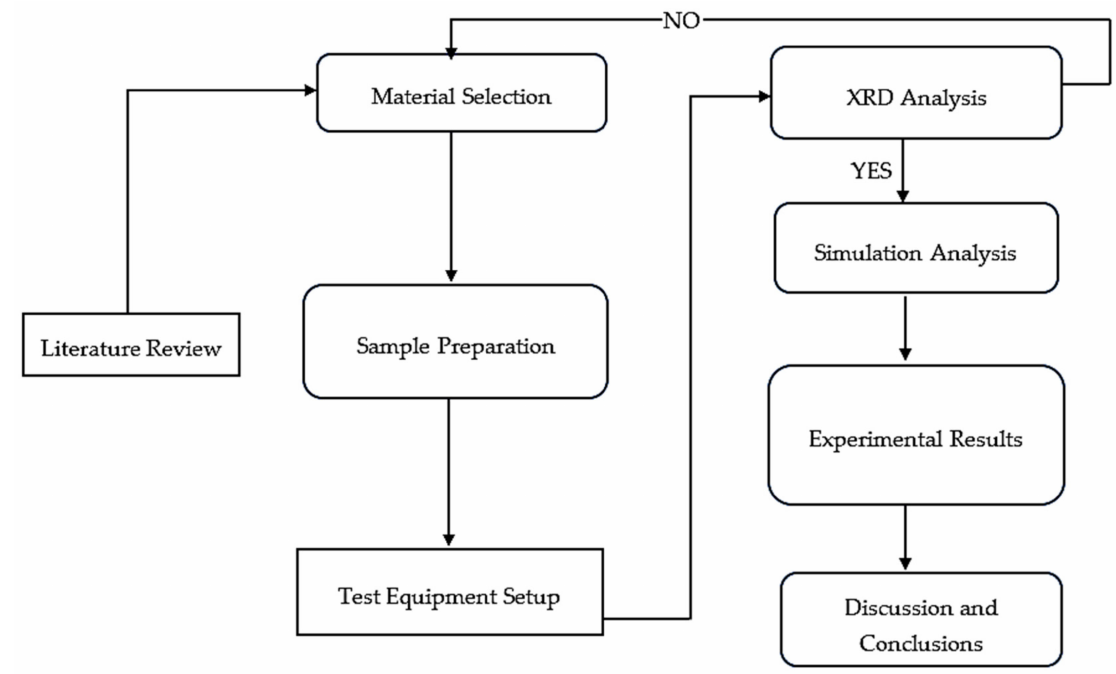
Figure 3. Flowchart of